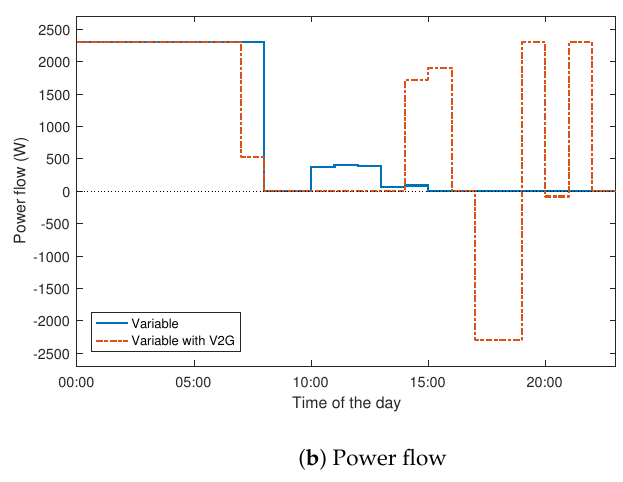
Figure 7. Charge schedule with and without V2G.